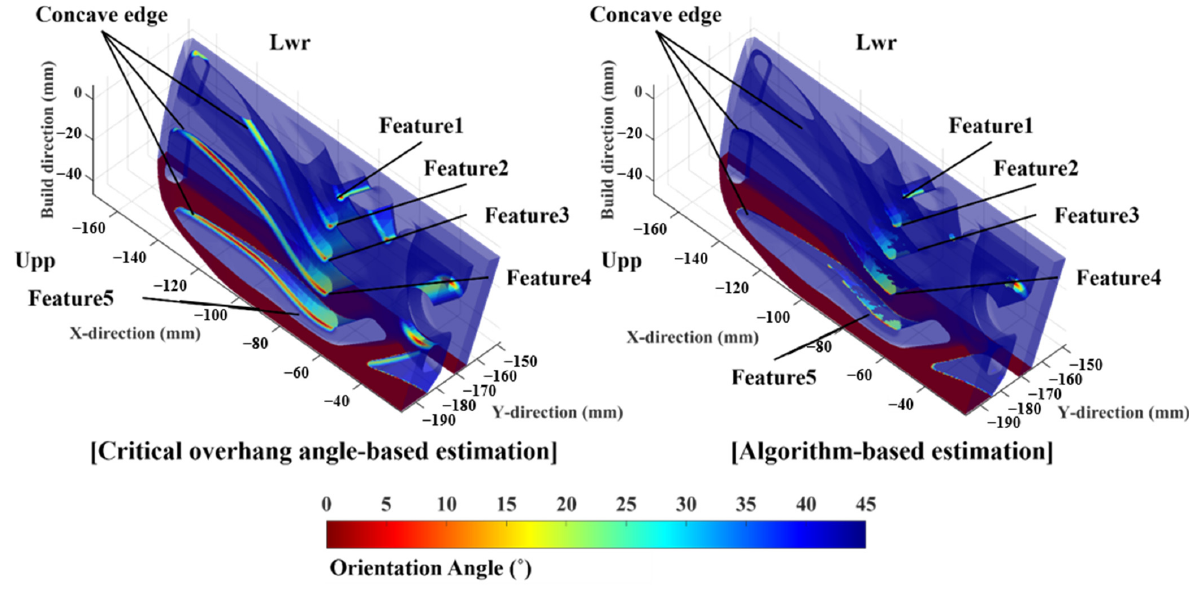
Figure 26. Contours of orientation angle and re-evaluated orientation angle yielded by the proposed algorithm over the surface of sample